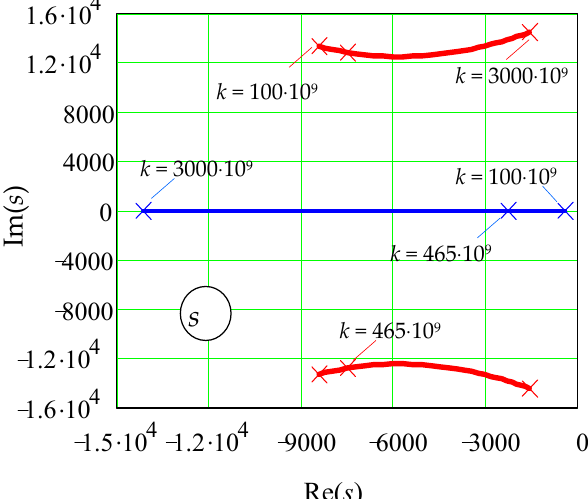
Figure 14. Root locus of characteristic polynomial for the range of transmission coefficient k = (100…465…3000) × 10 9 .